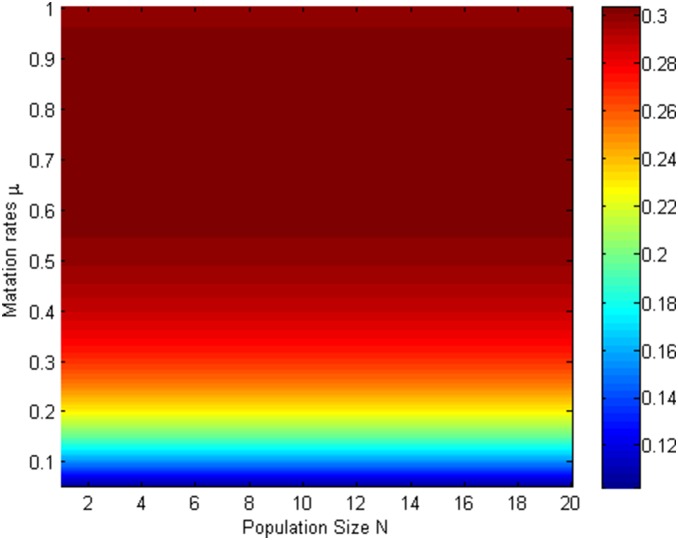
µ, m vs ρ1 with β = 0.01, b = 1.2.